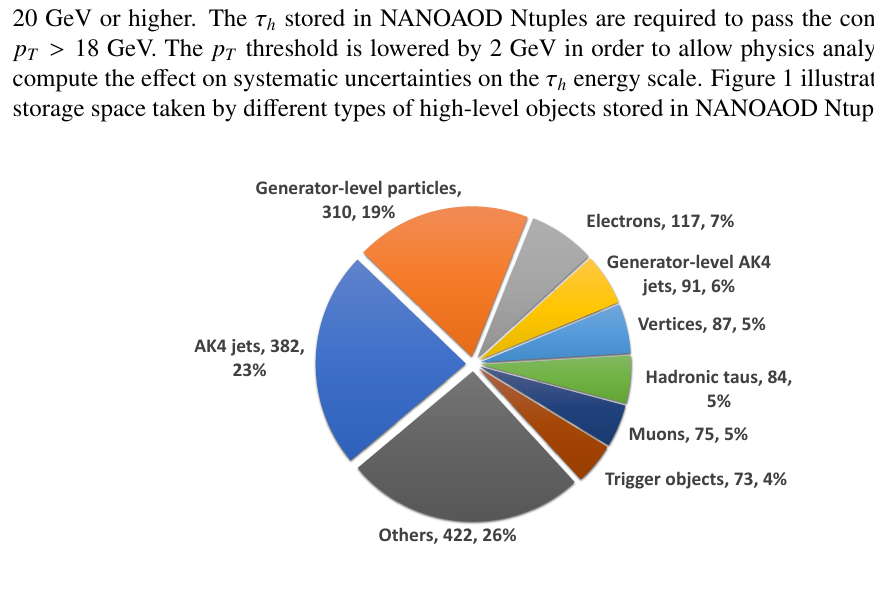
Figure 1. Breakdown of storage spaces taken by di ff erent high-level objects, on average per event, in a t ¯ t event sample produced by Monte Carlo simulation. The storage space is shown in bytes and in percentages relative to compressed event